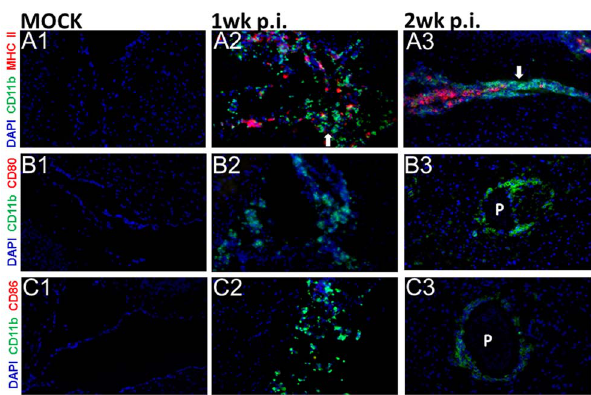
Figure 1. Infiltrating myeloid cells display reduced expression of surface maturation markers during murine NCC. In-situ IF staining was performed on frozen sections of HBSS infected (mock) and parasite infected brains of mice at 1 wk and 2 wk p.i. Brain cryosections were analyzed for expression of maturation markers MHC II, CD80, and CD86 using fluorochrome conjugated antibodies (red-PE) and macro- phages specific marker CD11b (green-Alexa 488). Nuclear staining DAPI is depicted in blue. Staining for these maturation markers MHC-II (A1), CD80 (B1), and CD86 (C1) was undetected/barely detected in mock infected mice. Parasite infected mice brains displayed large number of infiltrating myeloid cells stained positive for CD11b (A2–A3, B2–B3, and C2–C3). MHC-II was undetected in many of the CD11b + accumulated cells in the CNS of NCC mice at both 1 wk (A2) and 2 wk p.i. (A3) (arrow). CD80 (B2–B3) and Cd86 (C2–C3) were undetected/barely detected in the CD11b + myeloid cells around the parasite (P) in the CNS of NCC mice both at 1 wk and 2 wk p.i. Results are from one representative experiment of atleast three independent experiments (n=4 per each time